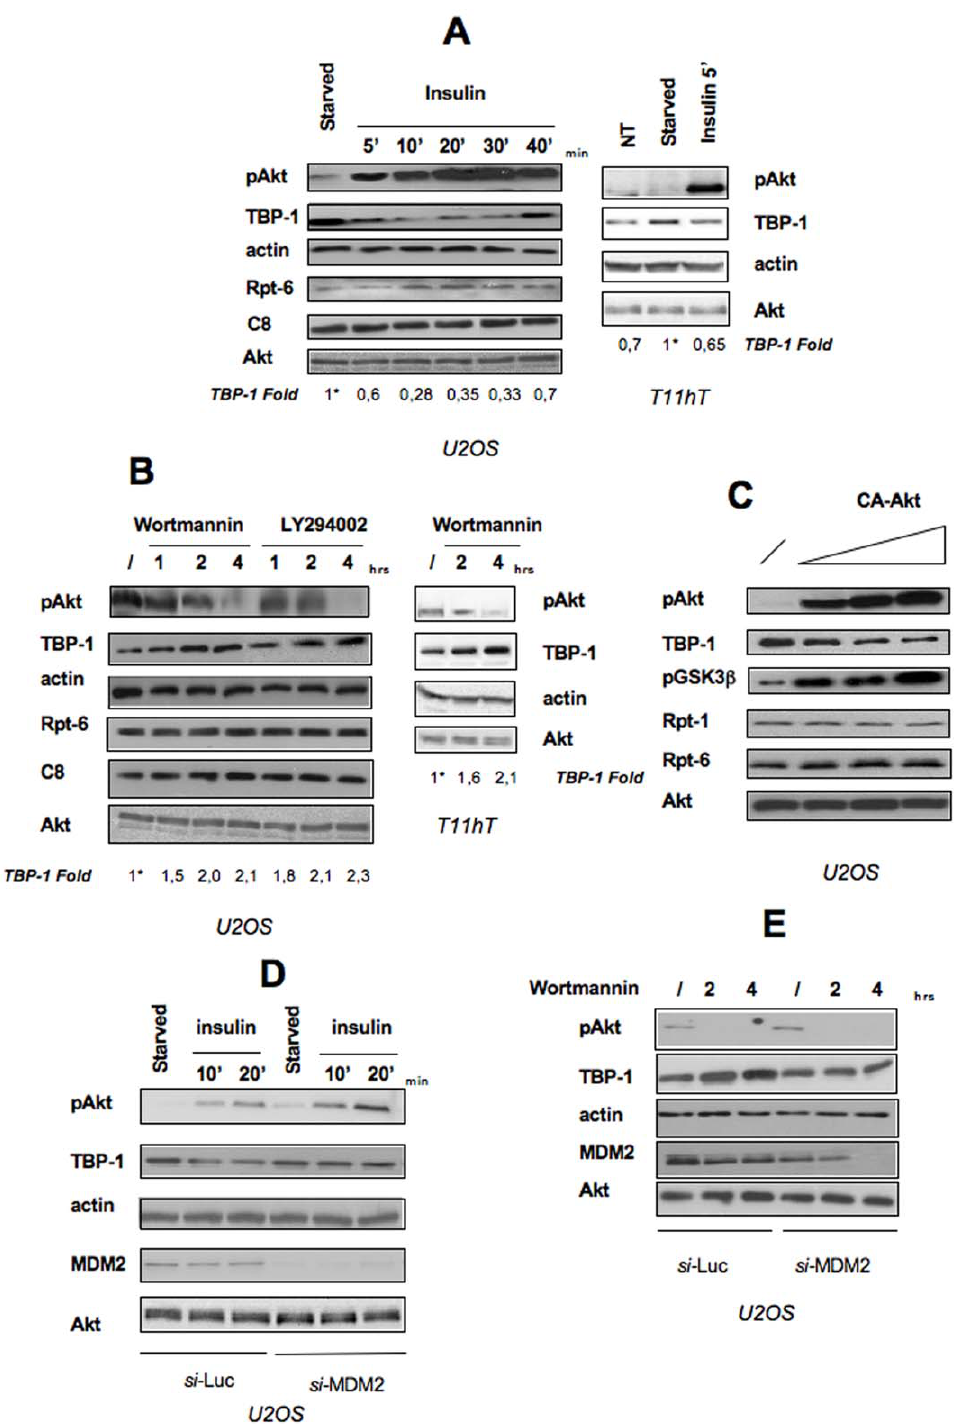
Figure 6. TBP-1 is a downstream target of Akt activation. A: U2OS cells or T11hT cells were starved for 4 hrs and then treated with 10 ng/ml insulin for the times indicated. Activation of Akt/PKB was evaluated by Western Blot on whole protein lysates probed with anti-Phospho-Akt Ser473 and anti-Akt. Levels of endogenous TBP-1 and of two proteasome components (C8 and Rpt-6) were analyzed where indicated. TBP-1 bands intensity was measured by ImageQuant analysis on two different expositions to assure the linearity of each acquisition, each normalised for the respective actin values. Asterisk, fold value is expressed relative to the reference point, (i.e. TBP-1 levels in starved cells) arbitrarily set to 1. Representative of three independent experiments. B: U2OS cells or T11hT cells were treated, 24 hrs after plating, either with DMSO (/) or with 200 nM Wortmannin or 50 mM LY294002 for the times indicated. Cells were then lysed and Western Blot analysis was performed by using specific antibodies against Phospho-Akt Ser473, anti-Akt, anti-TBP-1, anti-C8 and anti-Rpt-6. TBP-1 bands intensity was calculated as in A. Representative of three independent experiments. C: U2OS cells were transfected with empty vector (lane 1) or increasing amounts of the constitutive active mutant of the Akt kinase (CA- Akt). After 24 hrs cells were lysed and whole cell lysates probed with anti-Phospho-Akt Ser473, anti-Akt, anti-TBP-1, anti-Rpt-1, anti-Rpt-6, and anti-